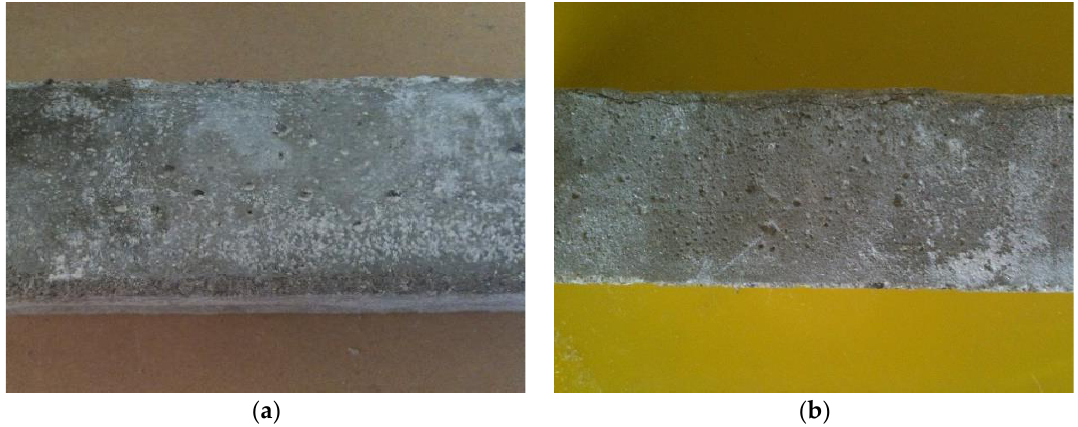
Figure 10. Polymer-cement mortar, p/c = 0.20, stored in 5% MgSO 4 solution: ( a ) after 12 months; ( b ) after 42 months.